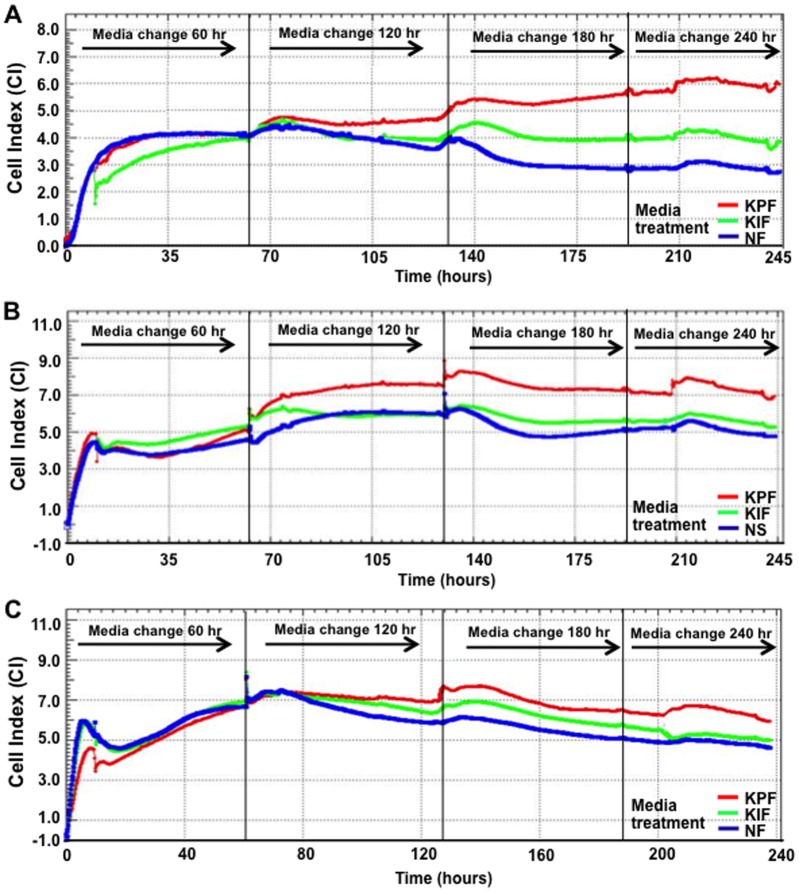
Real Time Cell Analysis (RTCA) over 240 hrs.
A. Increased CI was observed at 60–240 hrs. PKF and IKF media treatment both elicited higher CI than NF media between 60–240 hrs. B. Similar trend for NS treated with PKF, IKF and NS control media was observed but with PKF media eliciting maximum CI at 120 hrs. C. Differences in CI were smaller for PKF with all media treatments, although overall CI values were greater at 60 hrs. CI = cell index, NF = normal dermal fibroblasts (n = 4), NS = Normal dermal scar fibroblasts (n = 4), PKF = peri-lesional keloid fibroblasts (n = 5), IKF = intra-lesional keloid fibroblasts (n = 5).